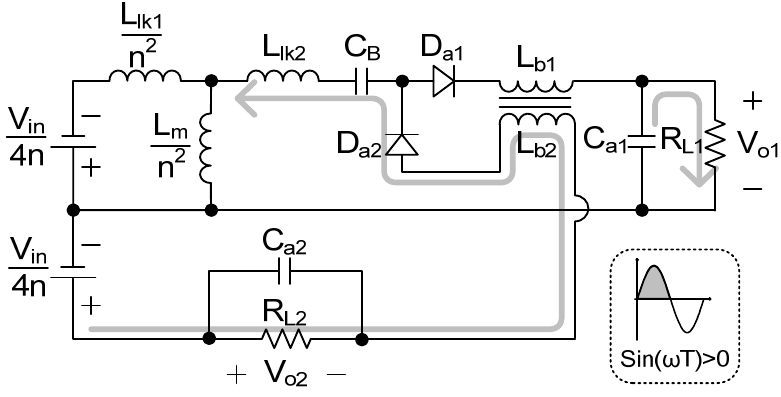
Figure 16. Equivalent circuit of secondary side converter (Sin ω t > 0).